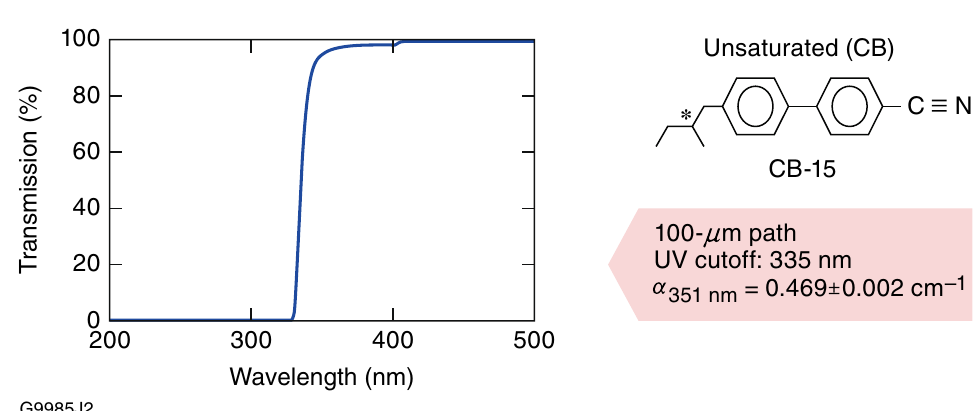
Figure 9. Molecular structure and optical absorbance data for a 100- µ m pathlength of pure chiral-dopant CB-15 used in 6601-1CB at a 1-wt% doping